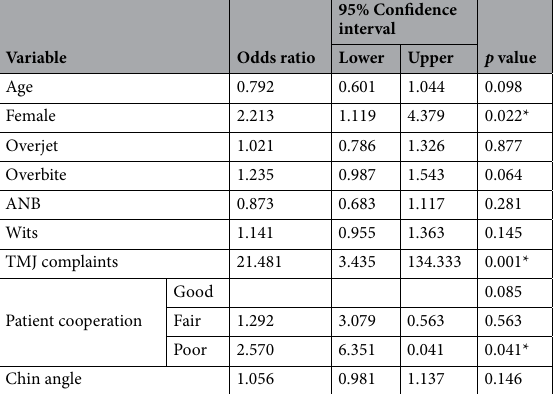
Table 6. Logistic regression model for skin irritation according to the variables. * p <